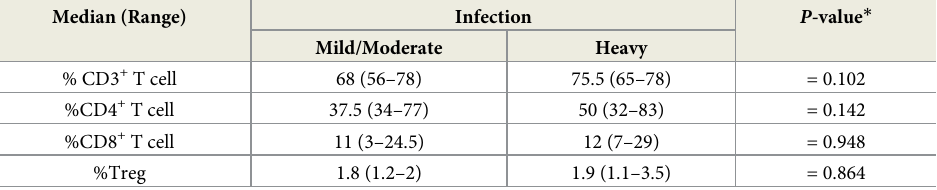
Table 4. Relationship between severity of infection and frequency of T lymphocyte subsets and Treg